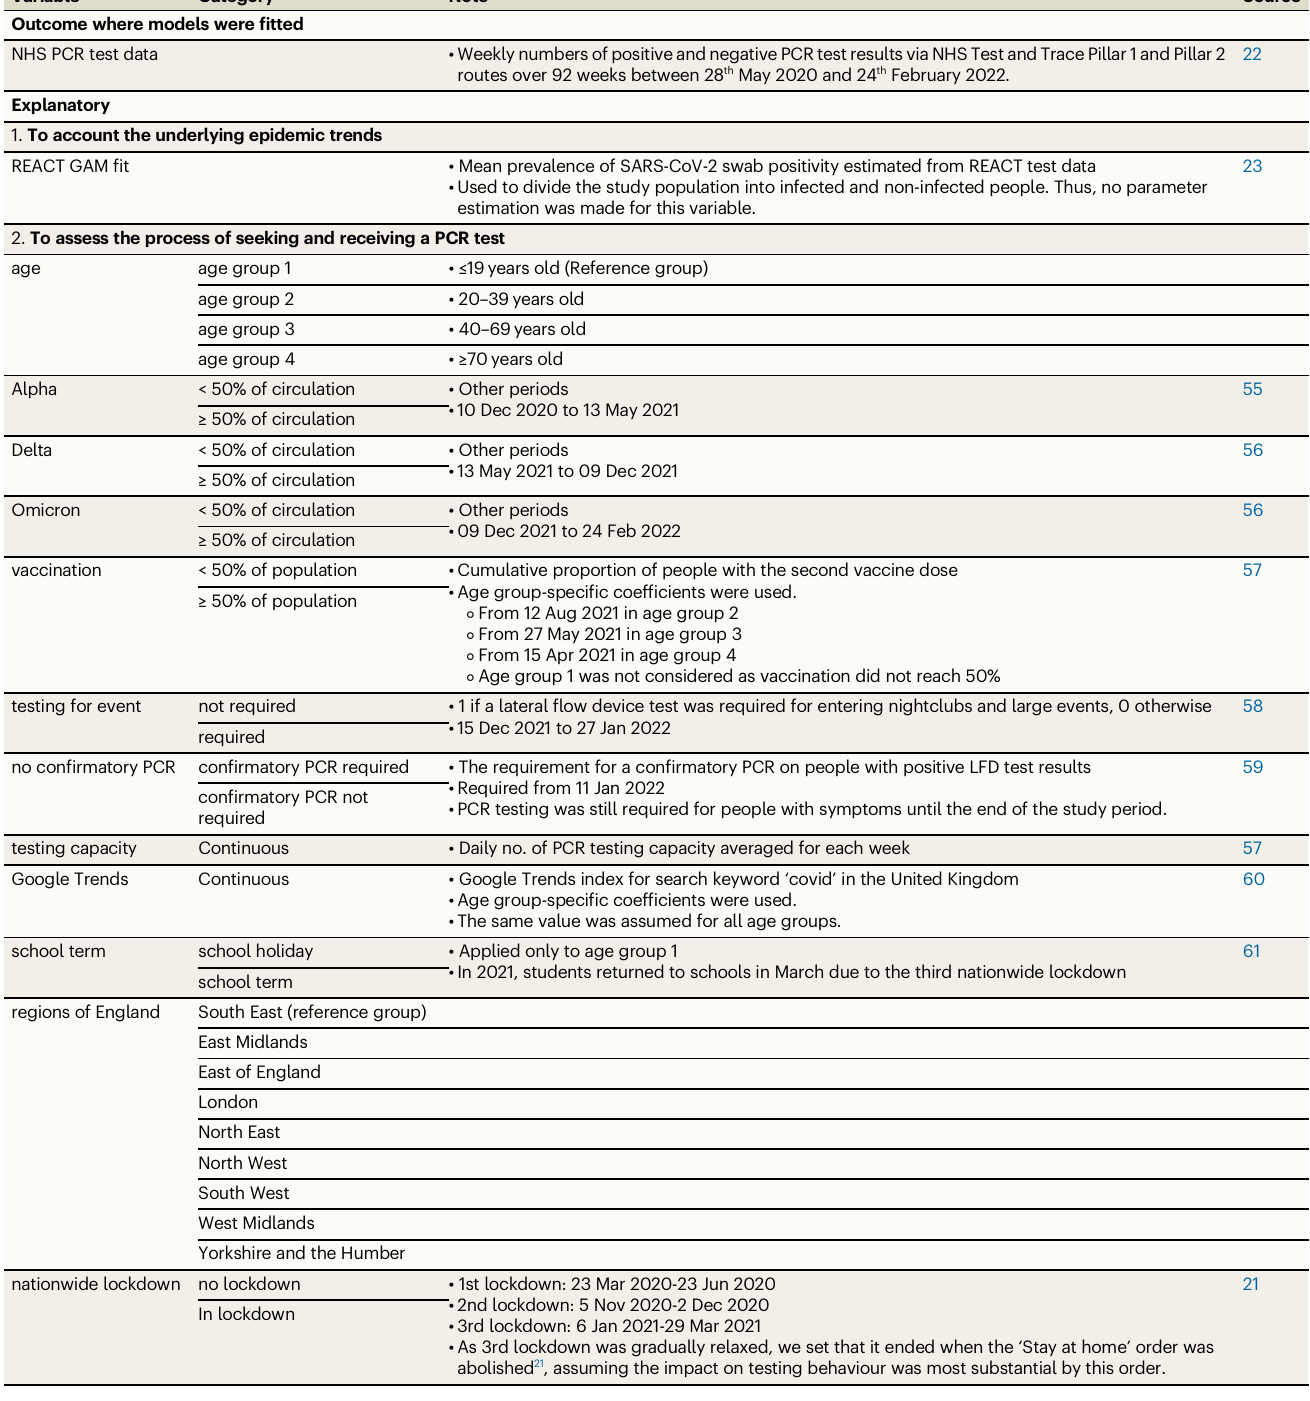
Table 1 | Use, de fi nition, and source of variables Variable Category Note Source Outcome where models were fi